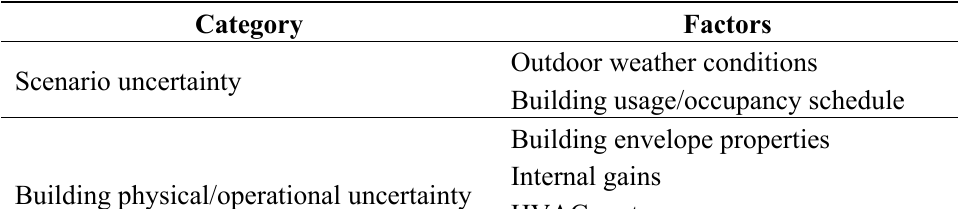
Table 3. Source of uncertainty in building energy models